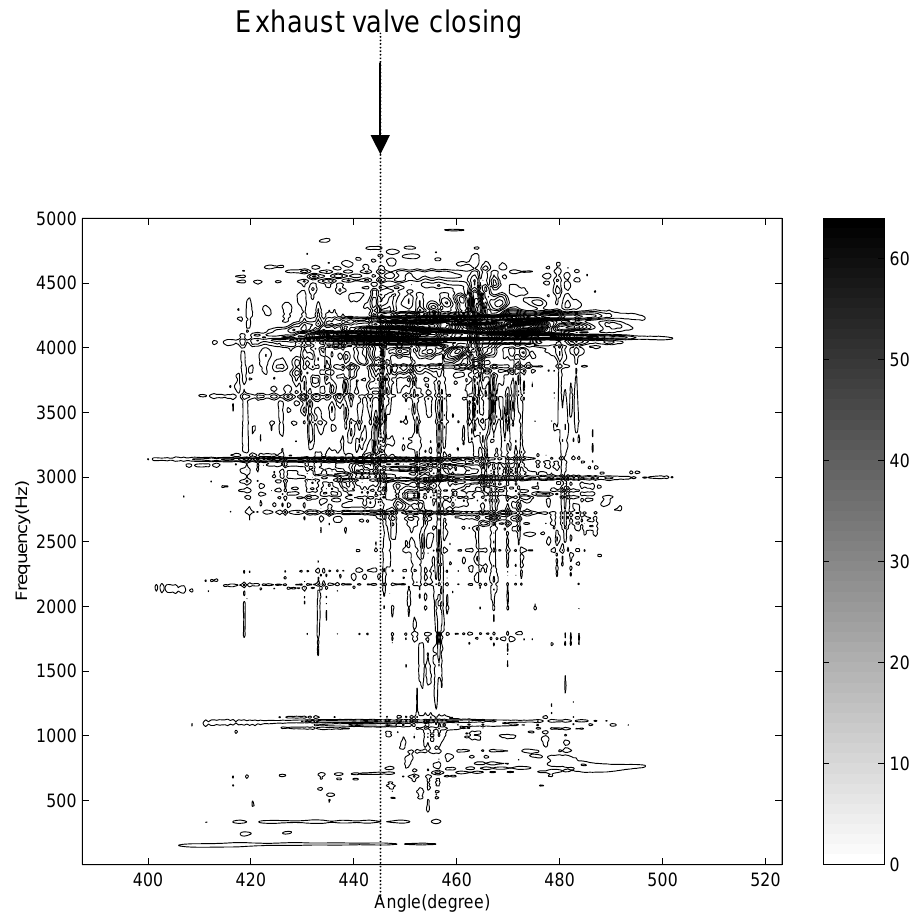
Fig. 7. Sliced Wigner forth order moment spectra smoothed by the exponential kernel for the enhanced signal after two stage